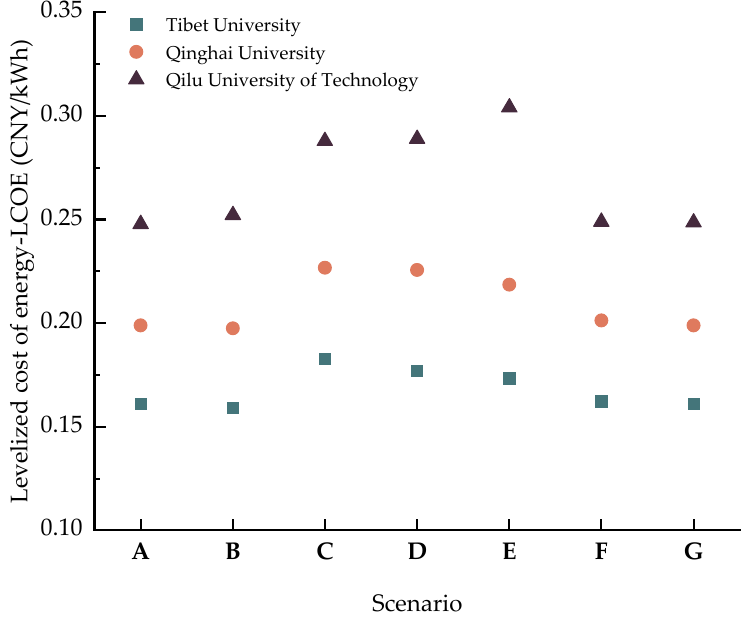
Figure 11. Levelized cost of energy in the three studied universities under seven scenarios.